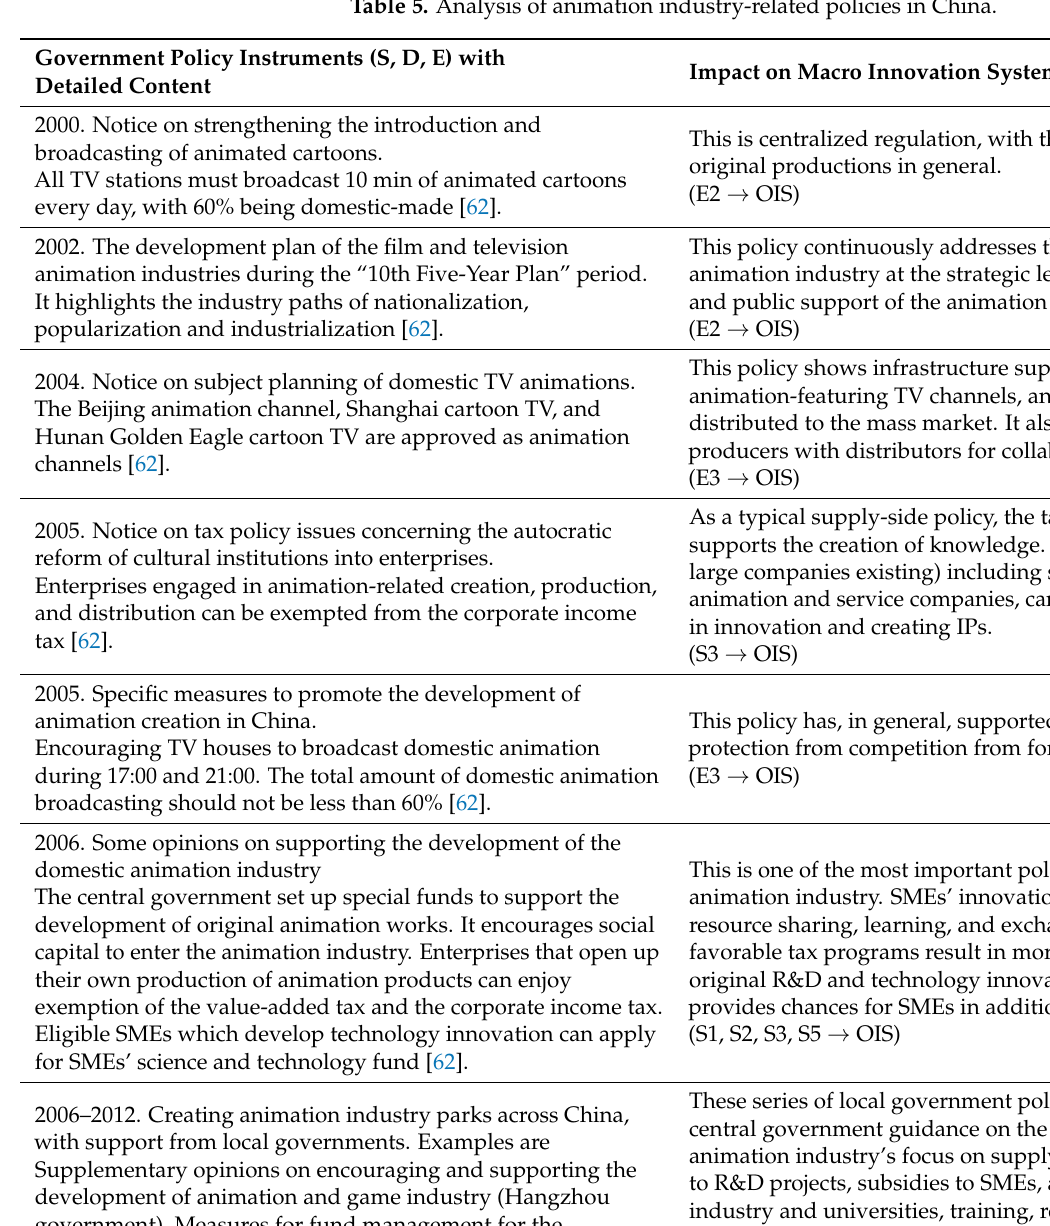
Table 5. Analysis of animation industry-related policies in